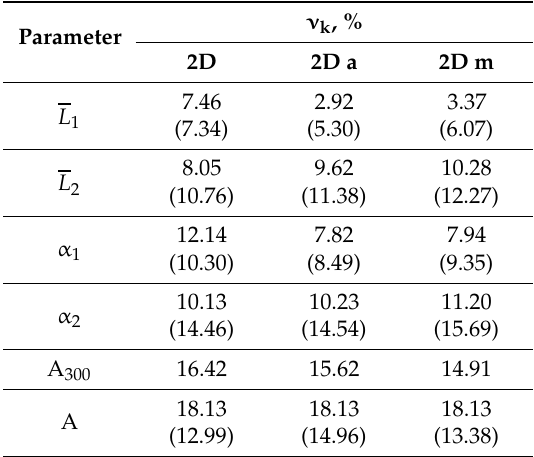
Table 6. Consistency of the results obtained by the given method with the standard-based results—root mean square relative deviation of all the